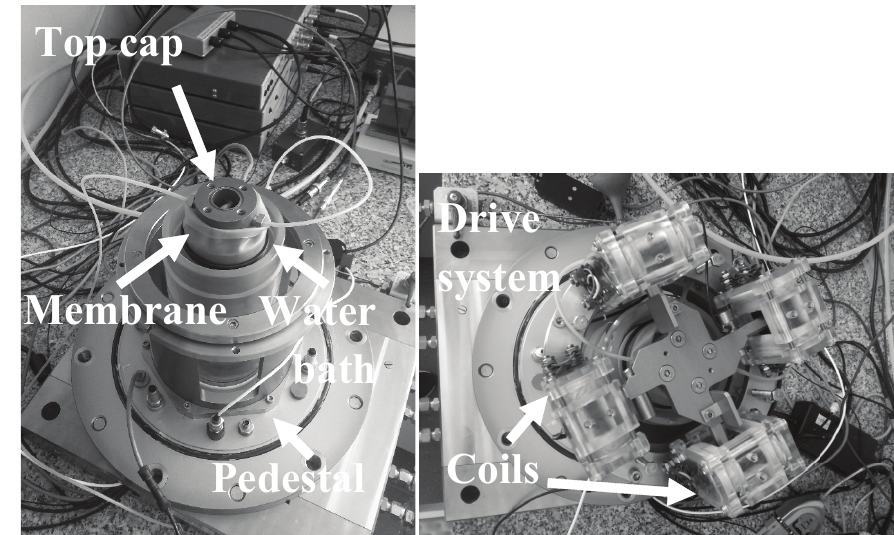
Fig. 5. Arrangement of the RCA